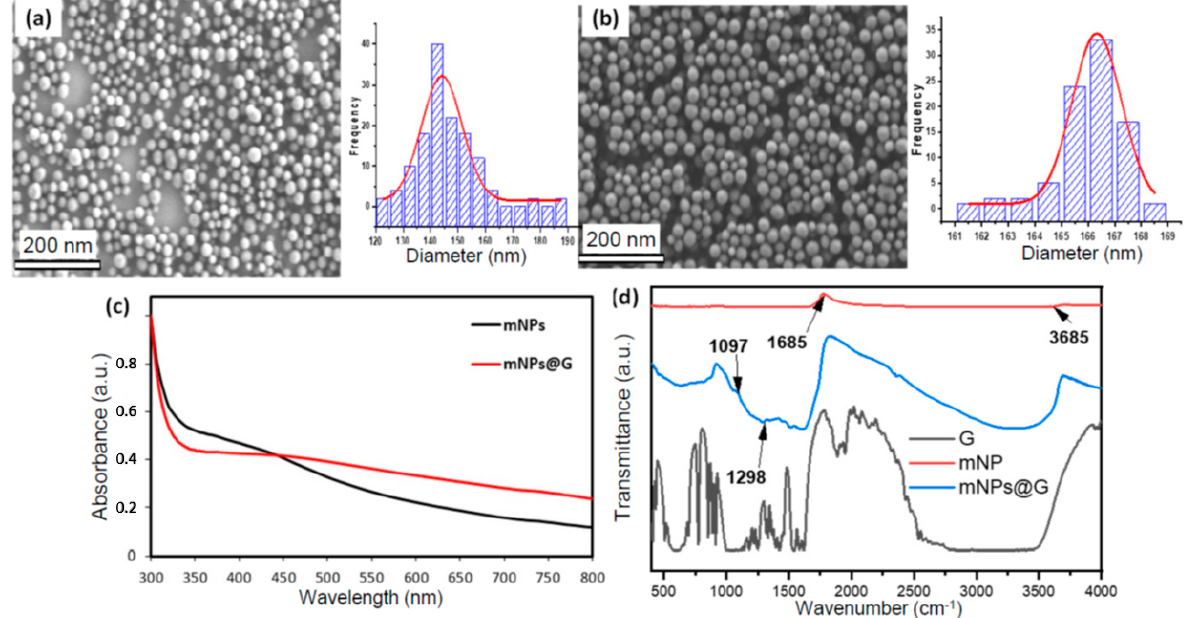
Figure 2. ( a , b ) SEM images and the corresponding size distribution histograms for mNP and mNP@G, respectively; ( c ) UV-Vis absorption of mNP (black) and mNP@G (red line). ( d ) FTIR spectra of terminal amino glucose (black line), mNP (red line), and mNPs@G (blue line).